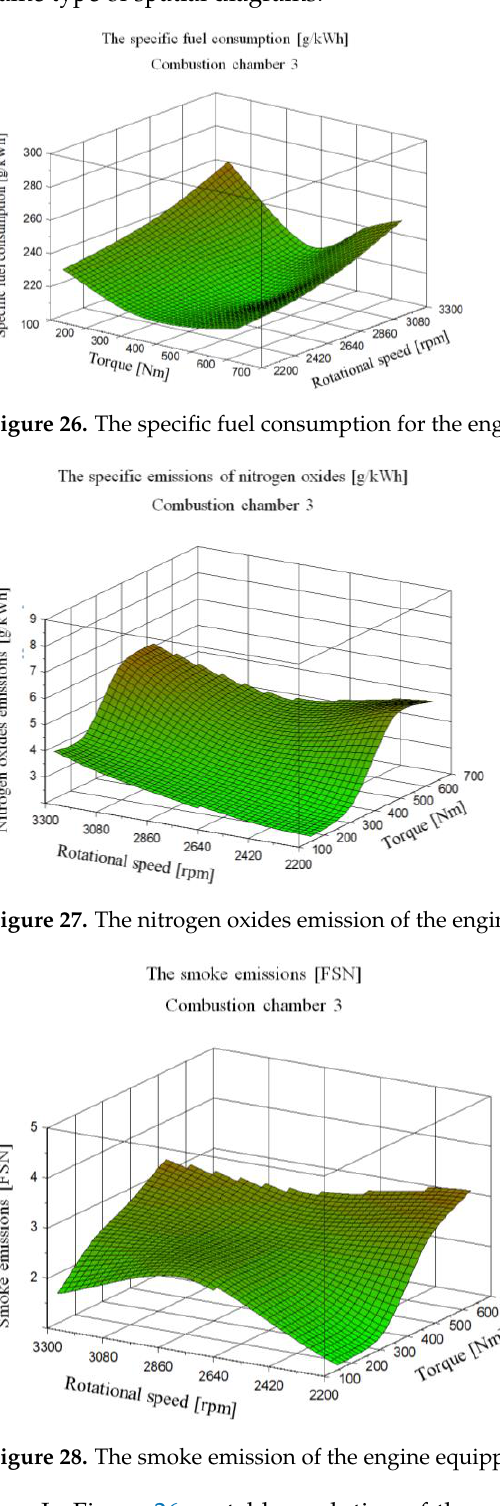
Figure 28. The smoke emission of the engine equipped with the combustion chamber 3.